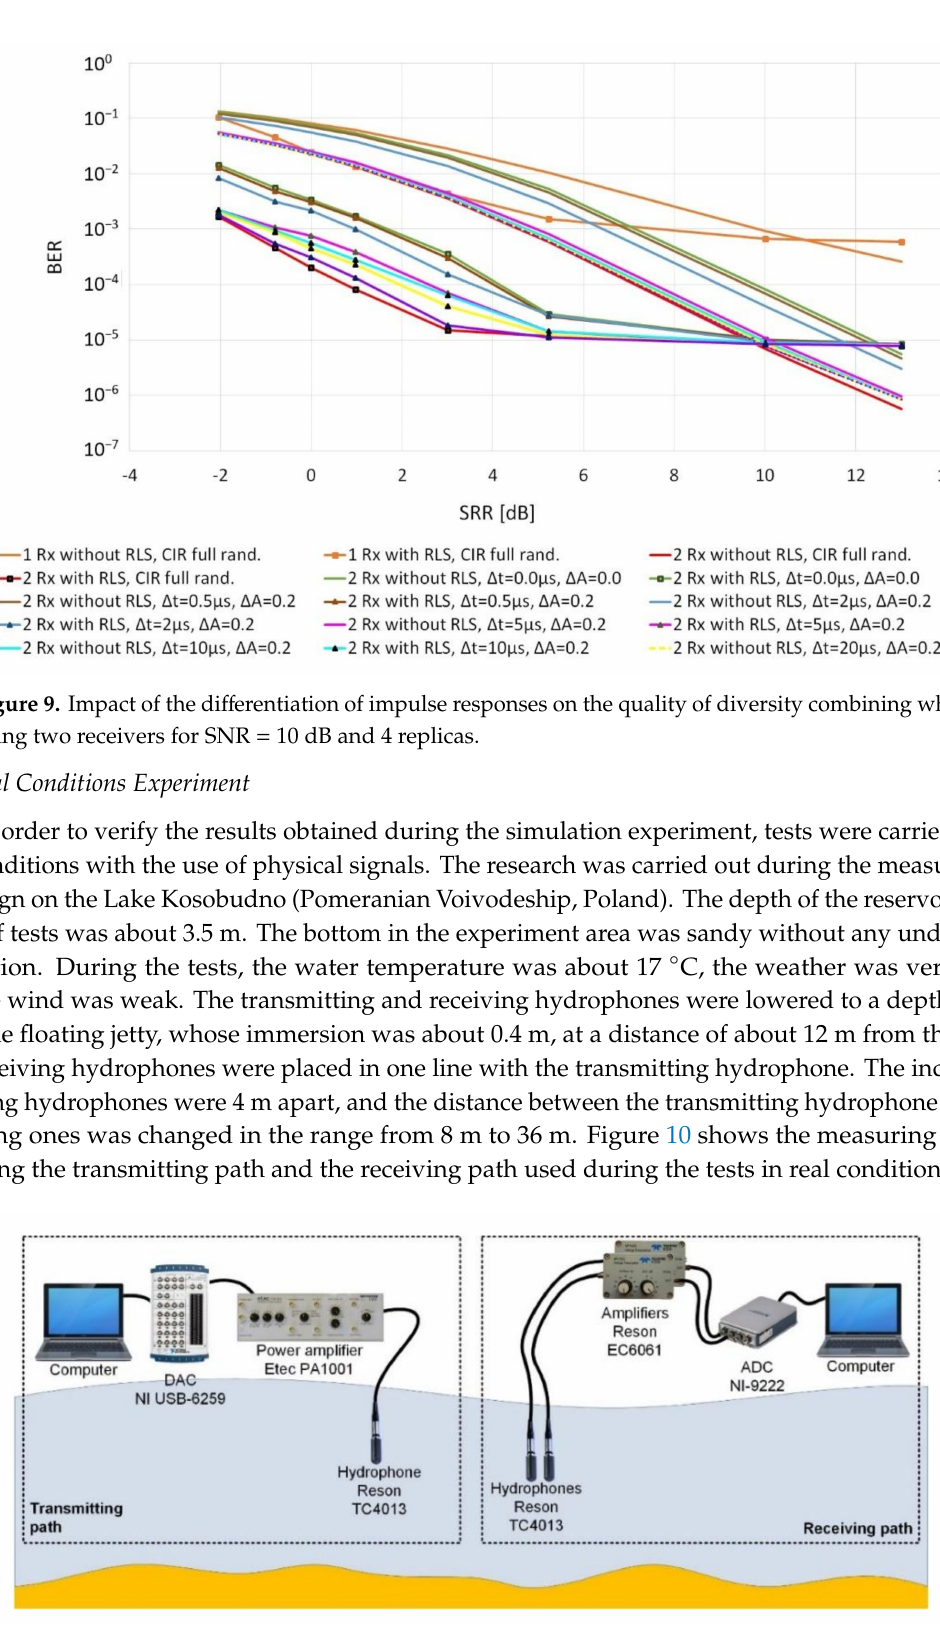
Figure 10. Block diagram of the measurement